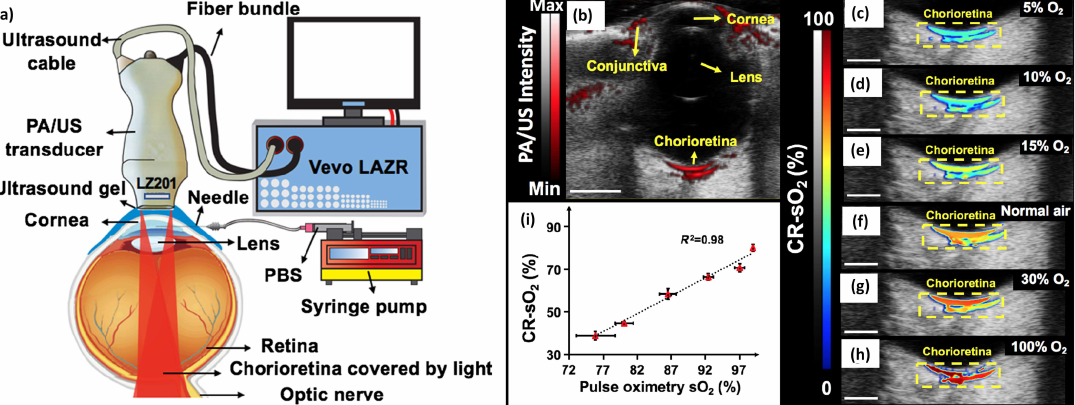
Figure 11. ( a ) Integrated PAOM and OCT for the quantification of a retinal oxygen metabolic rate. (a1) shows an en face PAM image of the retinal and choroidal vessels obtained at the wavelength of 570 nm. (a2) En face OCT image, (a3) B-scan OCT image acquired along the white circle in (a1), (a4) phase shift OCT image, and (a5) measured flow rate in the retinal and venous systems [9]. ( b ) Functional imaging of relative hemoglobin content (“CHb”), SO 2 saturation, and blood velocity in the angiogenic corneal network obtained using PAOM. The iris vasculature, which is pseudo-colored in gray based on vessel depth, is visible in the background of each image [85]. Adapted with permission from [9,85].